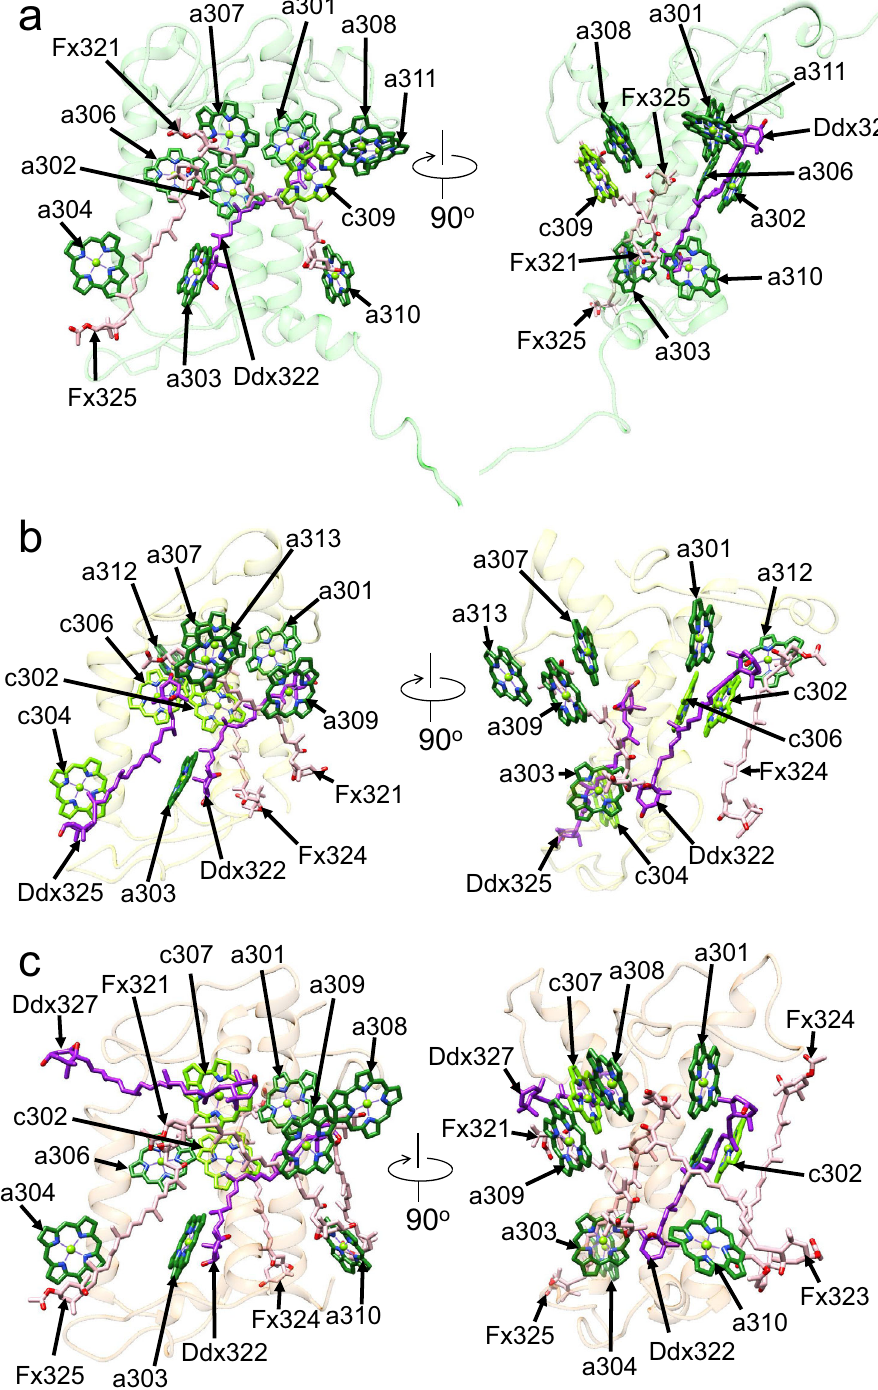
Fig. 4 Structure of the three types of monomeric FCPs. Structures of m1-Fcpb5 ( a ), m2-Fcpb6 ( b ), and m3-Fcpb7 ( c ) depicted with C α atoms and arrangements of the pigments (Chls and Cars), with the right-side panel rotated 90° clockwise relative to the left-side panel. The pigments of Chl a , Chl c , Fx, and Ddx are colored “ forest green ” , “ bright green ” , “ pink ” , and “ purple ” , respectively. Only rings of the Chls are (Fig. 4c and Supplementary Table 3). Compared with Sm1-Fcpb1, a310 are provided by side chains of E65, H68, E82, Q119, E128, three Chls c are substituted to a304/a306/a309, and one Chl a is E168, Q171, and H185, respectively (Supplementary Fig. 9c). replaced by c307 in m3-Fcpb7. One Chl a305 is lacking in m3- Since the ligand of a308 cannot be seen in the present structure, Fcpb7. Both hetero-dimeric c302/a306 and homo-dimeric a308/ its plausible candidate may be a water molecule. a309 are found in m3-Fcpb7. One Fx is substituted to Ddx322, whereas Fx326 is lacking and Ddx327 is present. The axial ligands Interactions among the FCPII units . The m3 subunit is closely of the Mg atom in a301, c302, a303, a304, a306, c307, a309, and associated with the M-tetramer as reported previously 7,8 . In